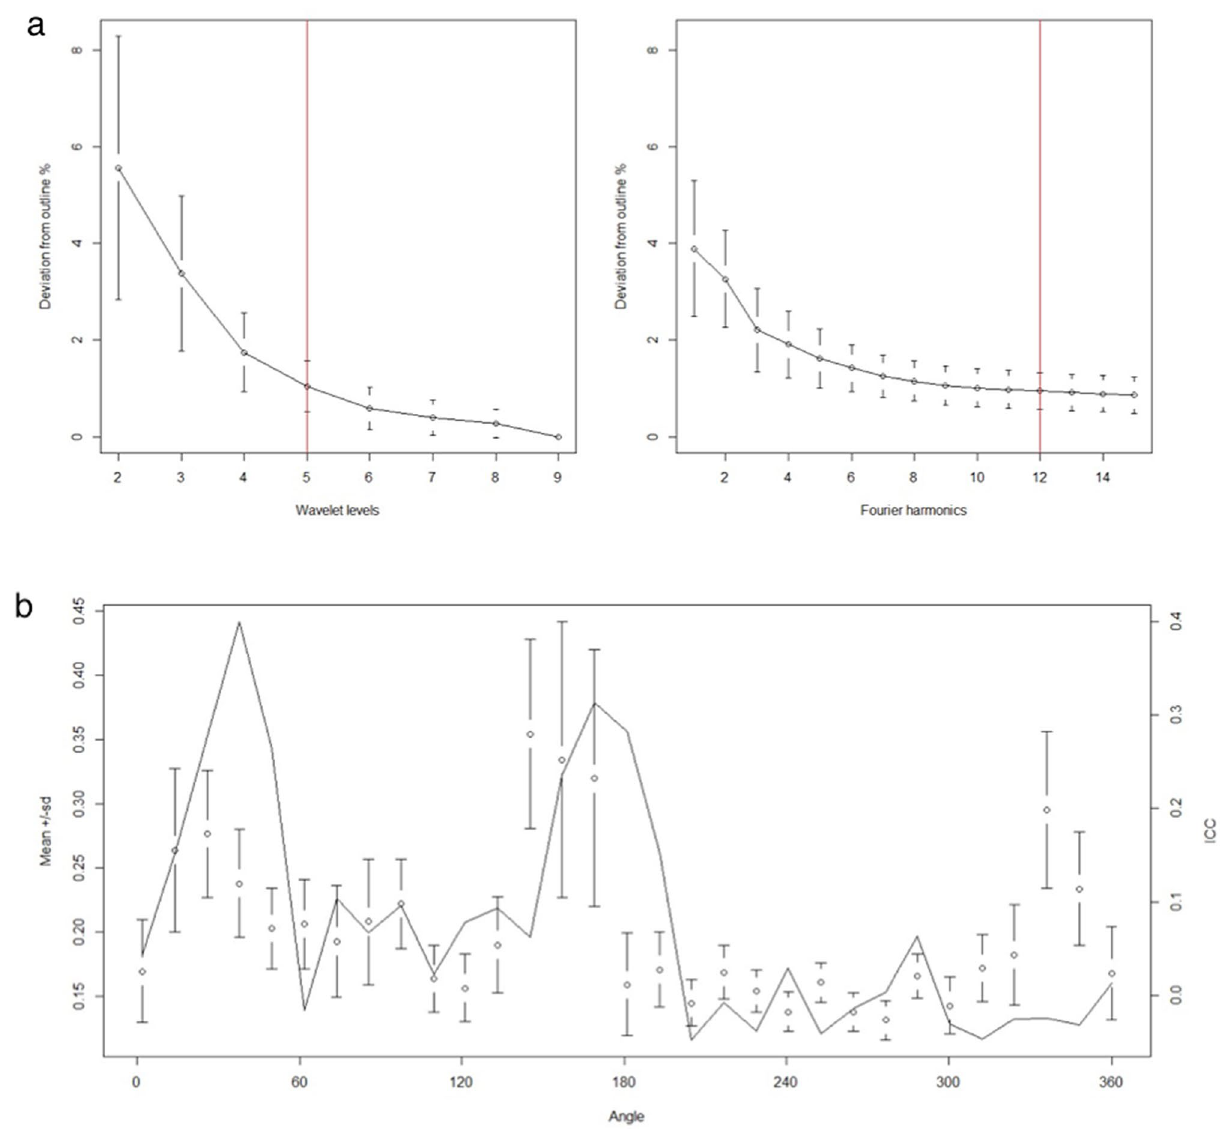
Figure 6. ( a ) Quality of the wavelet and Fourier outline reconstruction of left adult sagittae of studied species. The red vertical lines show the level of wavelet and number of Fourier harmonics needed for a 98.5% accuracy of the reconstruction. ( b ) Mean and standard deviation (SD) of the wavelet coefficients for all combined left adult sagittae of studied species and the proportion of variance among species or the intraclass correlation (ICC, black solid line). The horizontal axis shows an angle in degrees (°) based on the same polar coordinates of Fig. 1a, in which the centroid of the otolith is the center point of the polar